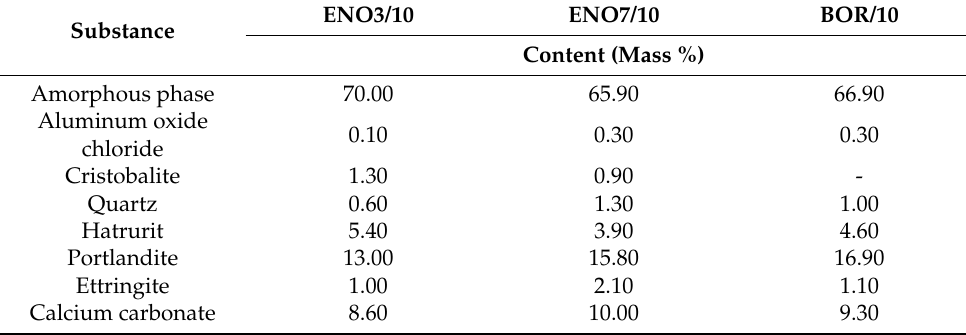
Figure 6. The calorimetric curves of tested pastes were obtained during the first 30 h. Table 9. Hydration heat of tested pastes relative to cement weight. Table 10. Results of XRD analysis of cement pastes after 1 h of hydration.